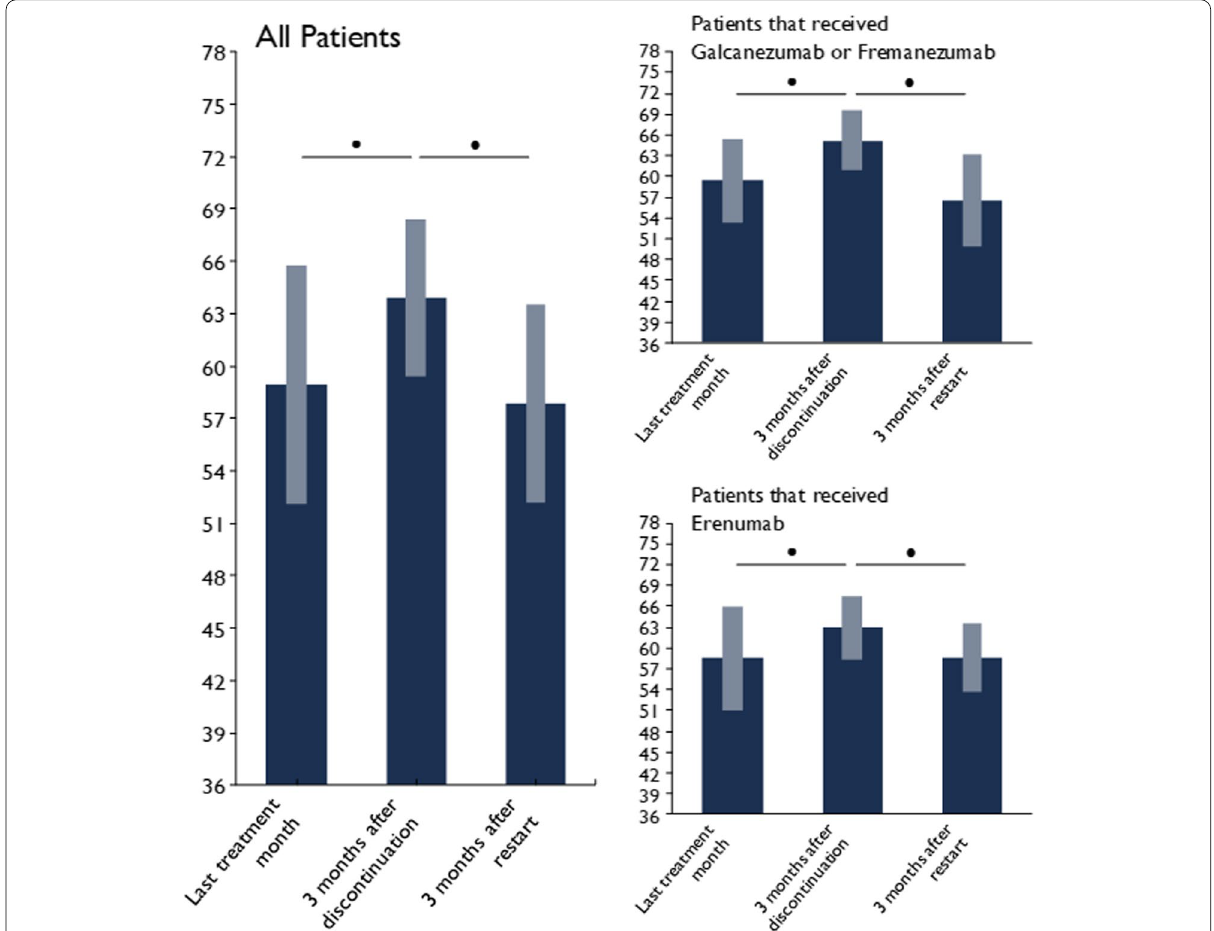
Fig. 3 Mean HIT-6 sum scores before, during and after treatment discontinuation. Values are mean